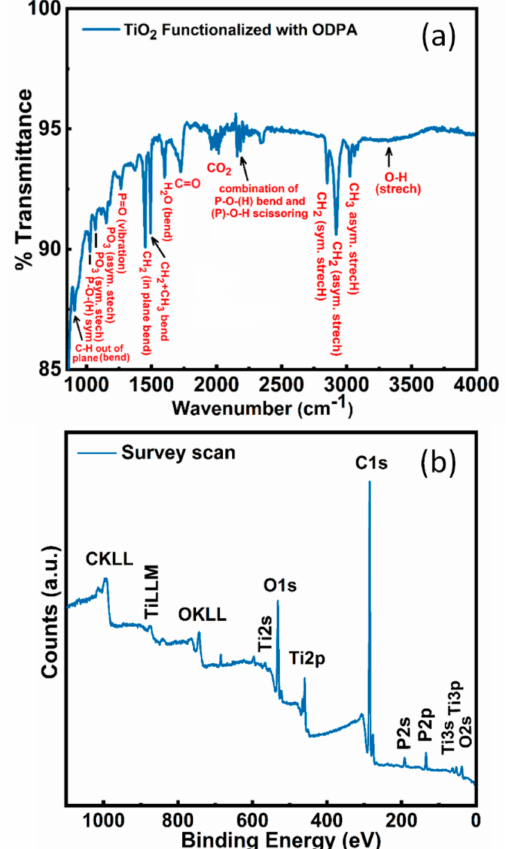
Figure 4. ( a ) FTIR spectra of ODPA functionalized TiO 2 NTs; ( b ) XPS elemental survey scan of ODPA functionalized TiO 2